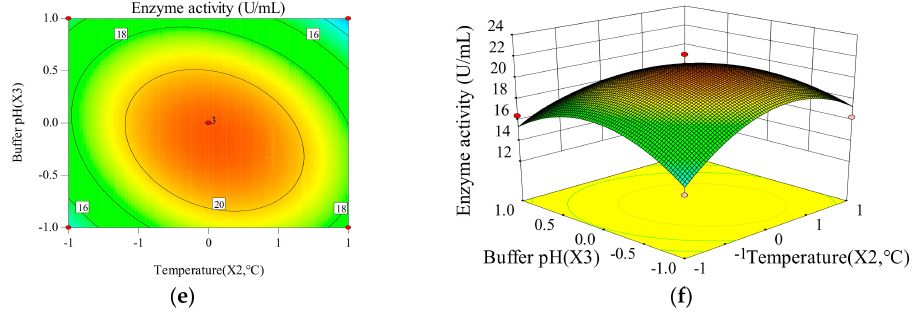
Figure 1. Contour plot of ( a ) time ( X 1 ) and temperature (X 2 ); ( b ) time ( X 1 ) and buffer pH ( X 3 ); ( c ) temperature ( X 2 ) and buffer pH ( X 3 ) and 3D plot of ( d ) time ( X 1 ) and temperature ( X 2 ); ( e ) time ( X 1 ) and buffer pH ( X 3 ); ( f ) temperature ( X 2 ) and buffer pH ( X 3 ) on enzyme activity of CEP from L. plantarum LP69.